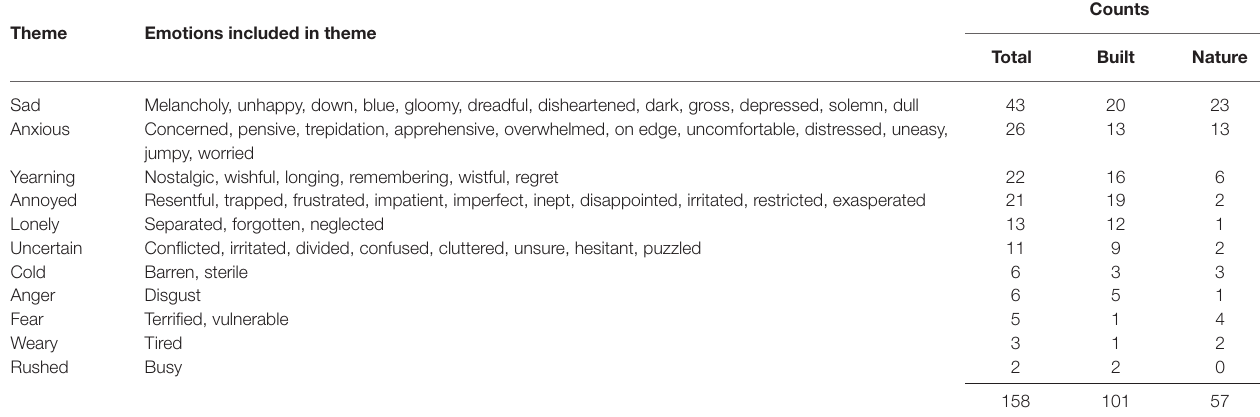
TABLE 5 | Negative emotion themes from content analysis.